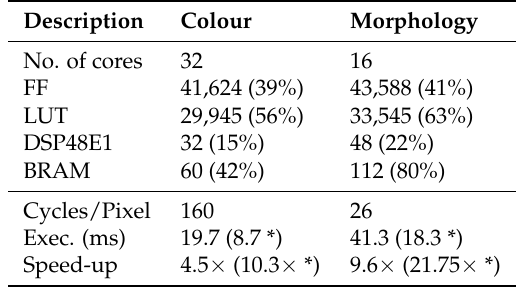
Table 11. IPPro-based acceleration of colour and morphology operations implemented on